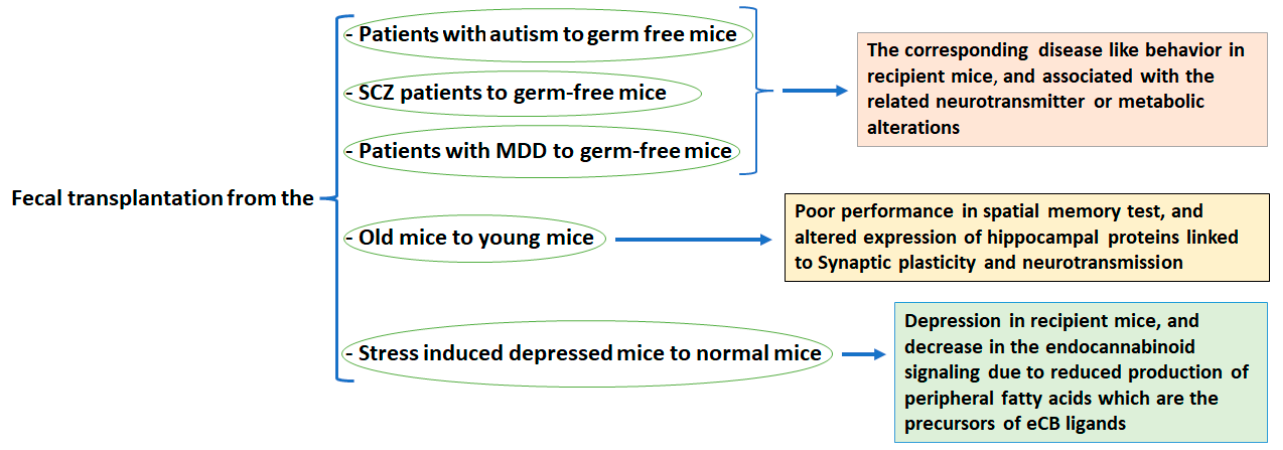
Figure 3. The proposed link between microbiome alterations and behavioral changes. Multiple lines of evidence support the finding that microbiota transplantations from the affected individuals or mice provoke the corresponding disease-like behavior in the recipient mice.